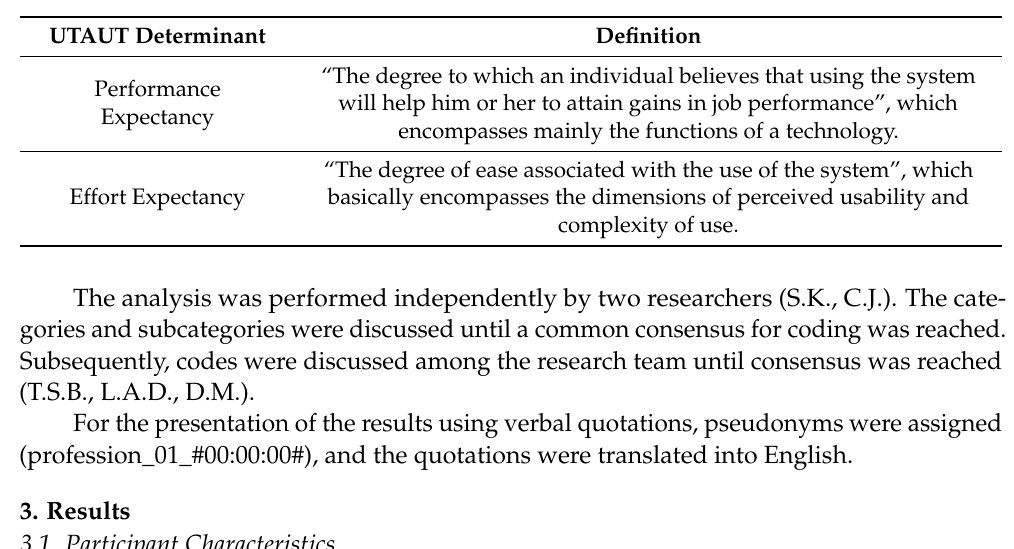
Table 1. Definitions of the core direct determinants of UTAUT [36].